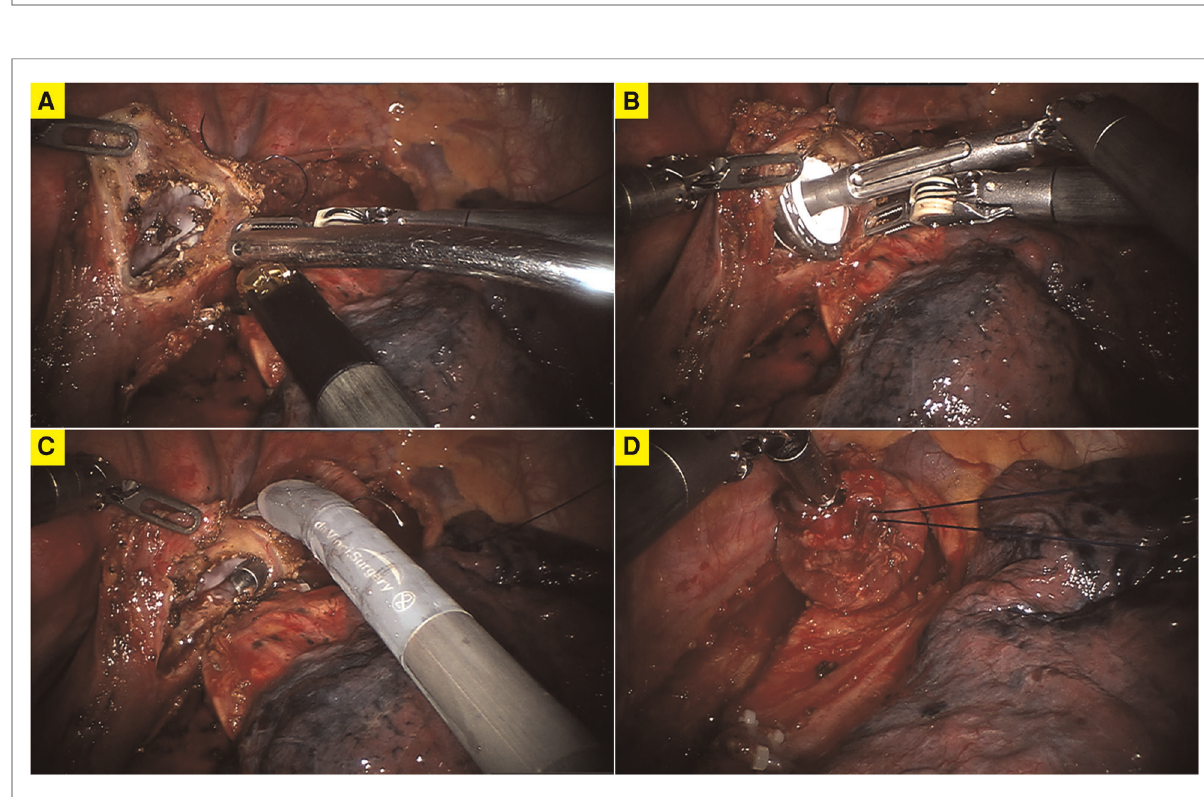
FIGURE 1 The fi rst robotically sewn purse-string suture of the muscular layer of the esophagus; A . diagram illustrating the fi rst robotically sewn purse-string suture; B . surgical picture of the fi rst robotically sewn purse-string suture.